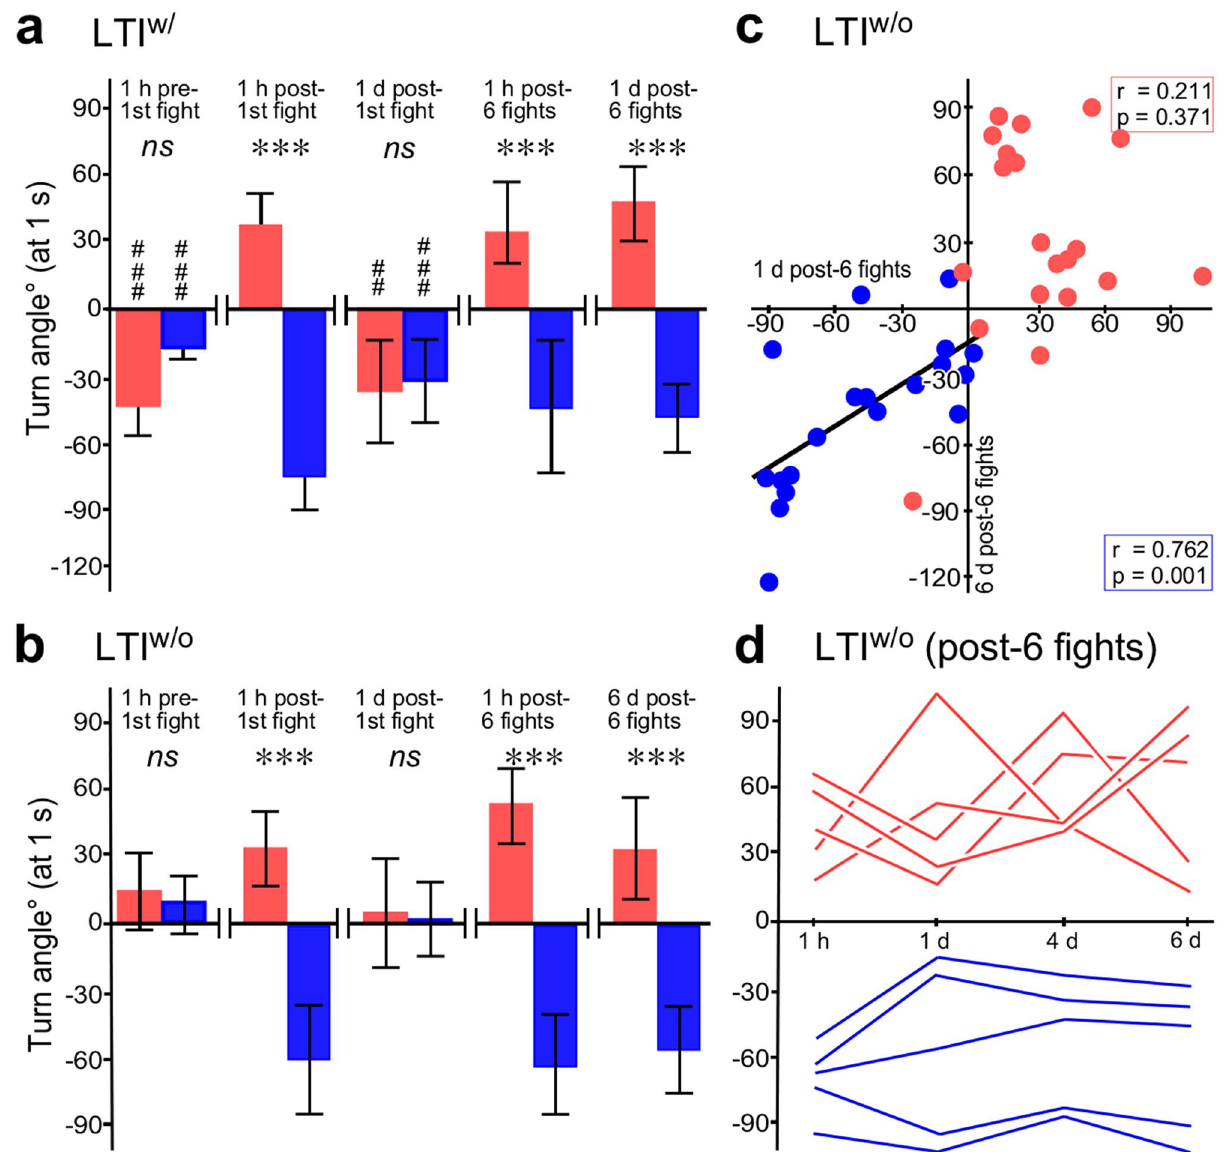
Figure 4. Turn angles for long term isolates 1 s after stimulus. ( a , b ) Box plots for LTI w/ respectively LTI w/o crickets (red and blue bars: means for winners and losers respectively, whiskers: 95% CI). Asterisks indicate differences between groups and hashtags differences to zero: ns not significant, *** p < 0.001; # p < 0.025, ### p < 0.0005 (Bonferroni corrected alpha for 3 comparisons = 0.017). Note: the last bar chart in ( b ) is for data 6 days after 6 fights, in contrast to ( a ). ( c ) Plots of individual turn angles on day 1 versus day 6 after 6 fights for LTI w/o winners and losers (red and blue circles respectively, n = 20 each). ( d ) Sequential plots of mean turn angles at different time points over a period of 6 days following 6 fights for randomly selected winners and losers (red and blue lines respectively, n = 5 each). All components of the figures were created with canvas DRAW 5 for MAC (Version 5.0.2, ACD Systems, https:// www. acdsy stems. com/